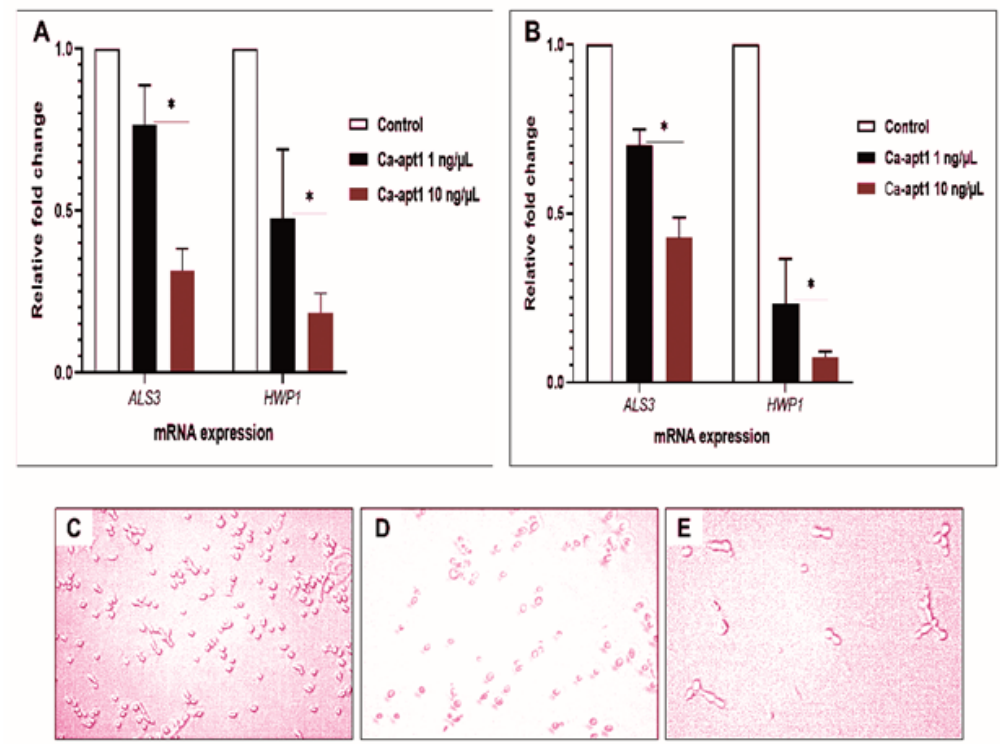
Figure 2. Induction of selected biofilm-associated genes by C. albicans following precoating with different concentrations of Ca-apt1. The upper panel shows the effect of precoating aptamer on ALS3 and HWP1 expressed by C. albicans in preformed biofilm (90 min incubation time) were analysed by qPCR. The mRNA expression levels were normalized relative to the control (yeast cells without aptamer precoating), which was set to one for each gene to determine the fold change in expression of genes in C. albicans clinical isolate ( A ) and the ATCC 10231 ( B ). The results are expressed as the mean and standard deviation (SD) of triplicate experiments and repeated two times independently. *Significantly higher downregulation in the expression of mRNA (P < 0.05) in the presence of precoating aptamer. The lower panel is representative of micrograph of C. albicans yeast cell (that only shown in clinical isolate) without precoating aptamer ( C ), and the reduced germinated cells after incubating for 90 min with precoating aptamer 1 ng/μL ( D ) and 10 ng/μL ( E ). All images were captured by using light microscopic at X 200